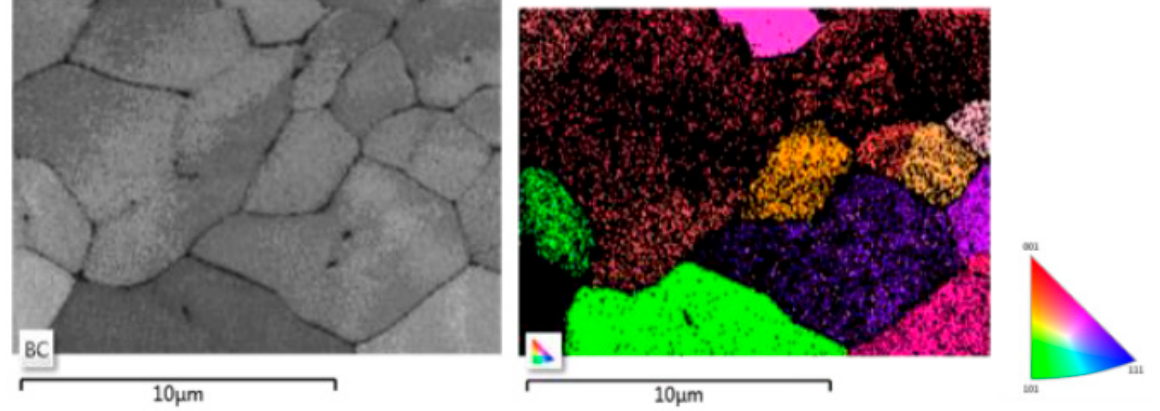
Figure 3. EBSD analysis of an as-atomized Al 6061 powder particle. The grayscale micrograph presents a band contrast image of the analyzed cross-sectional region considered the scanning area for EBSD-based characterization. The colored micrograph presents the inverse pole figure color map from the EBSD analysis. The Miller indices (001, 101, and 111) are also identified next to the inverse pole figure.